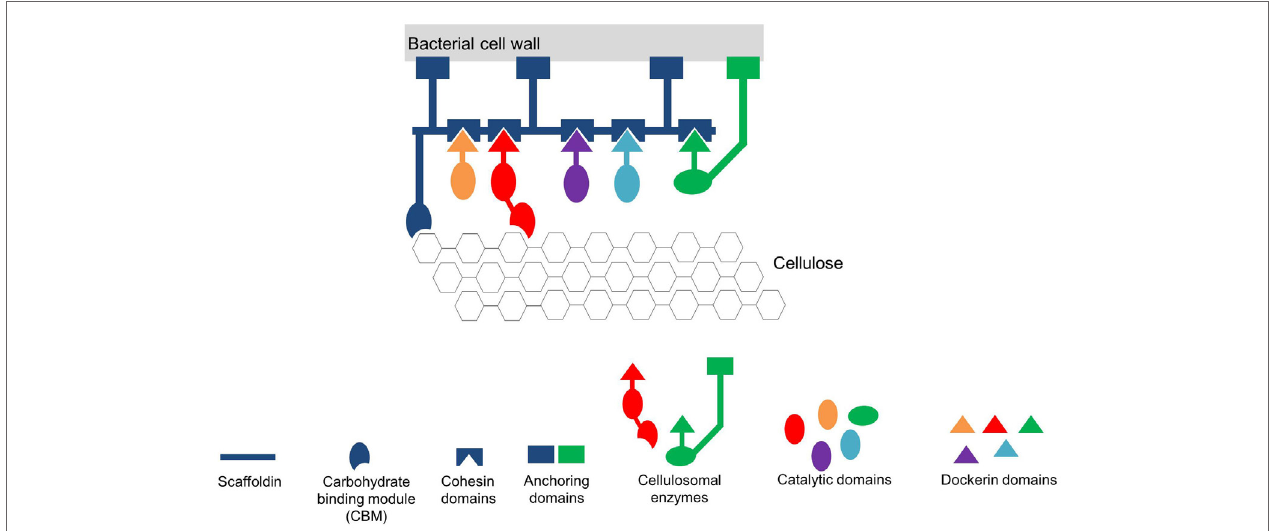
FiGURe 3 | Simplified scheme of the cellulosome from Clostridium thermocellum (adapted from Mazzoli et al., 2012). The Cellulosome in this scheme consists of a scaffold protein (Scaffoldin) that is composed of five Cohesin domains. The whole complex is connected to the bacterial cell wall via protein anchors. Each enzyme has its own specific Dockerin domain. By specifically interacting, the Cohesin- and the Dockerin domains form the multienzyme complex in close vicinity to the substrate cellulose. To further increase the affinity of the multienzyme complex toward the substrate the whole scaffold is linked to the substrate via carbohydrate binding modules